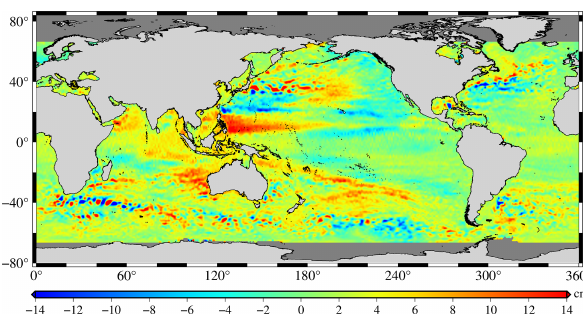
Figure 4. Sea surface height differences between Jason-1/GM and the SDUST2020 model after oceanic variability